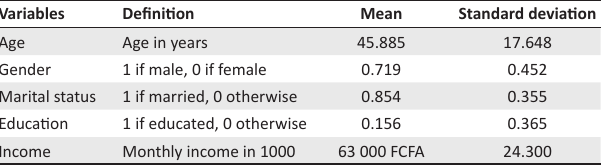
TABLE 1: Summary statistics of surveyed respondents.